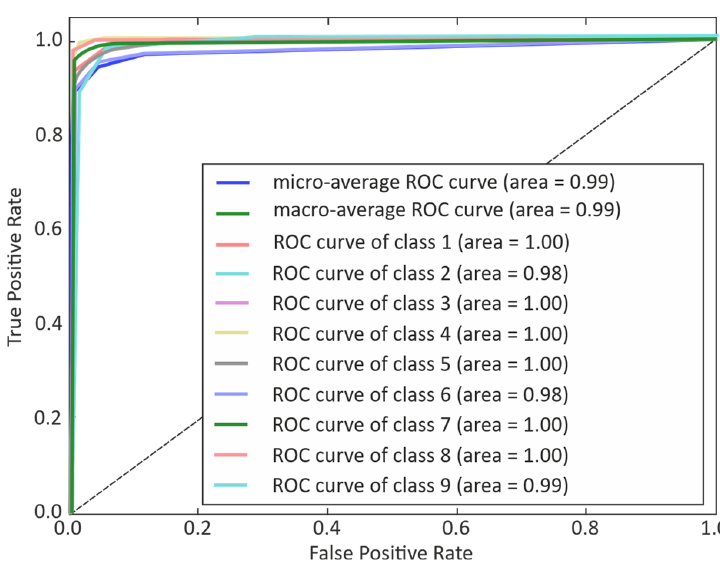
Figure 4. ROC plot for RF classifier (micro-averaged 98%).